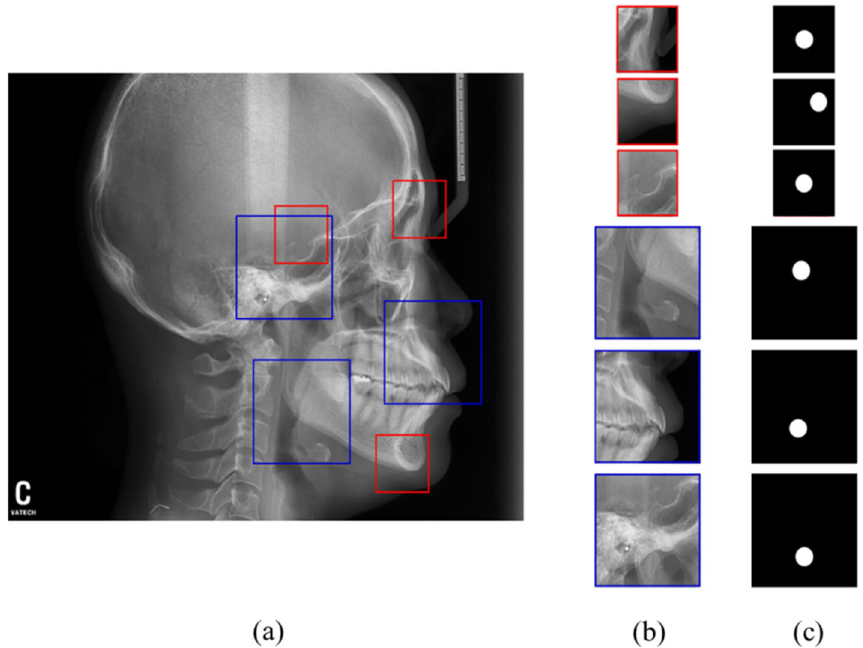
Figure 4. Regions of interests (ROIs) detection and landmark prediction results with different sizes depending on the information of each landmark. ( a ) Predicted ROIs (red and blue boxes) by RetinaNet algorithm, ( b ) ROI patches used for input of semantic segmentation for predicting a landmark, and ( c ) ground truth masks from the test set of each